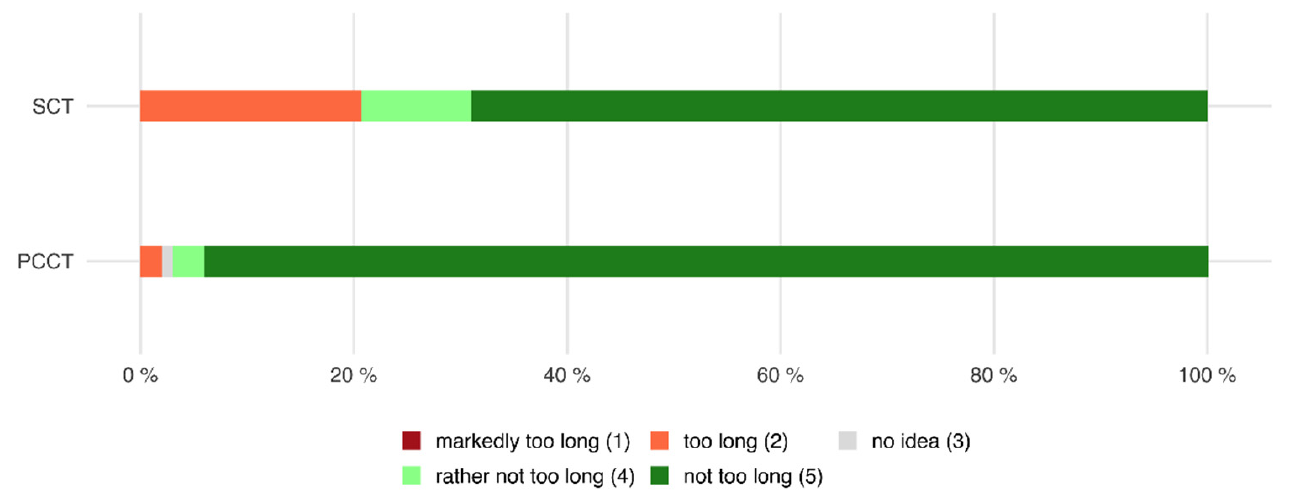
Figure 7. Horizontal stacked bar chart showing the perceived time to hold the breath. Patients had significantly less difficulty holding their breath when examined with the PCCT compared to the SCT (PCCT 4.9 ± 0.5 versus SCT 4.36 ± 1.2, p < 0.001).